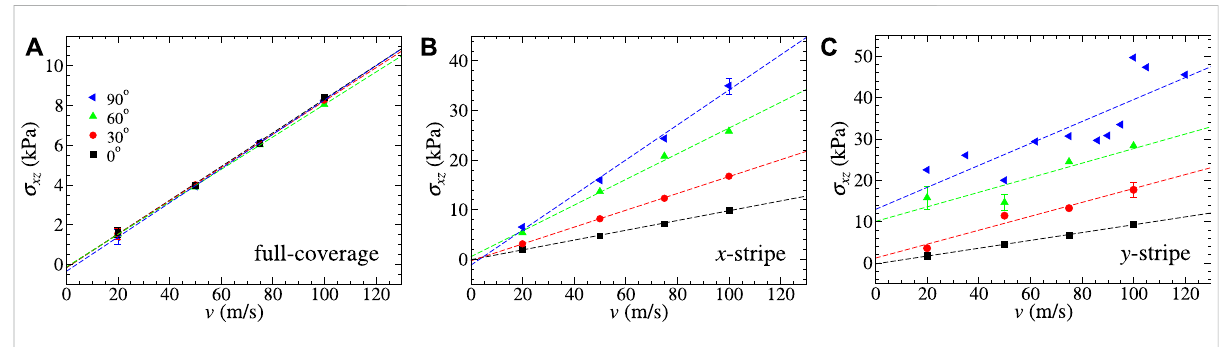
FIGURE 7 Dependence of shear stress on sliding velocity for (A) full coverage, (B) x -stripe, and (C) y -stripe using different sliding directions ranging from parallel (0 ° ) to perpendicular (90 ° ) to the contact line. Both the outermost layers are fl exible in all cases.